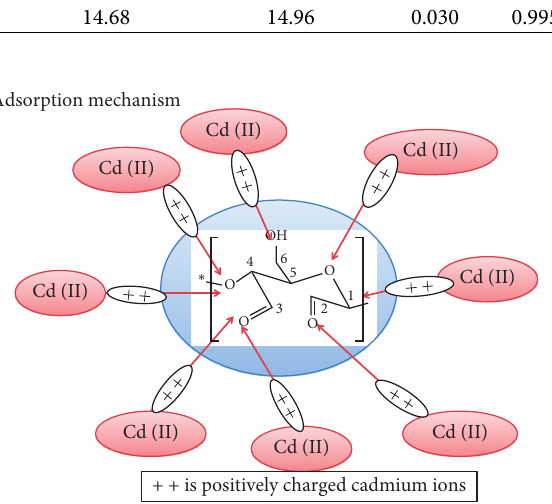
Figure 11: Adsorption mechanism of Cd(II) ion removal by CNCs.